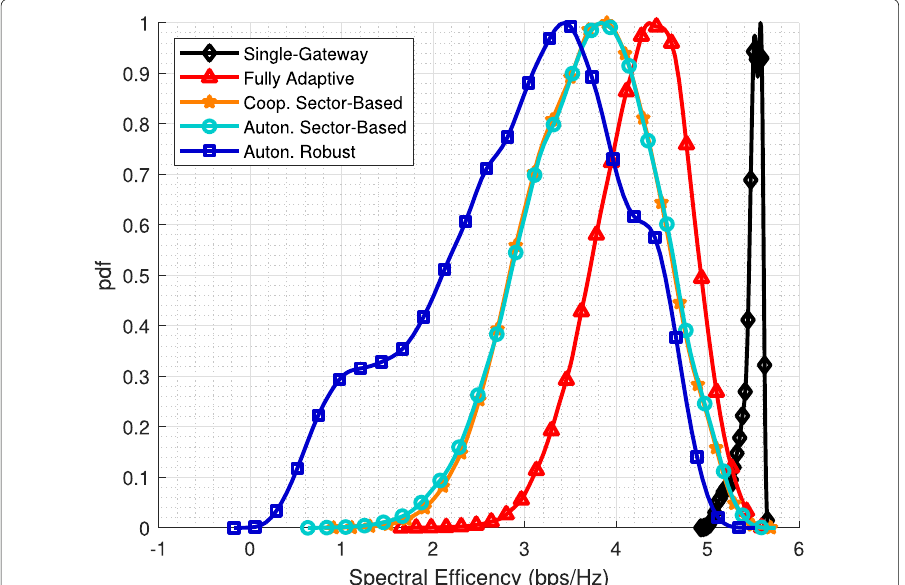
Fig. 14 Spectral efficiency pdfs for 1 user per frame (unicast mode). SNR = 20